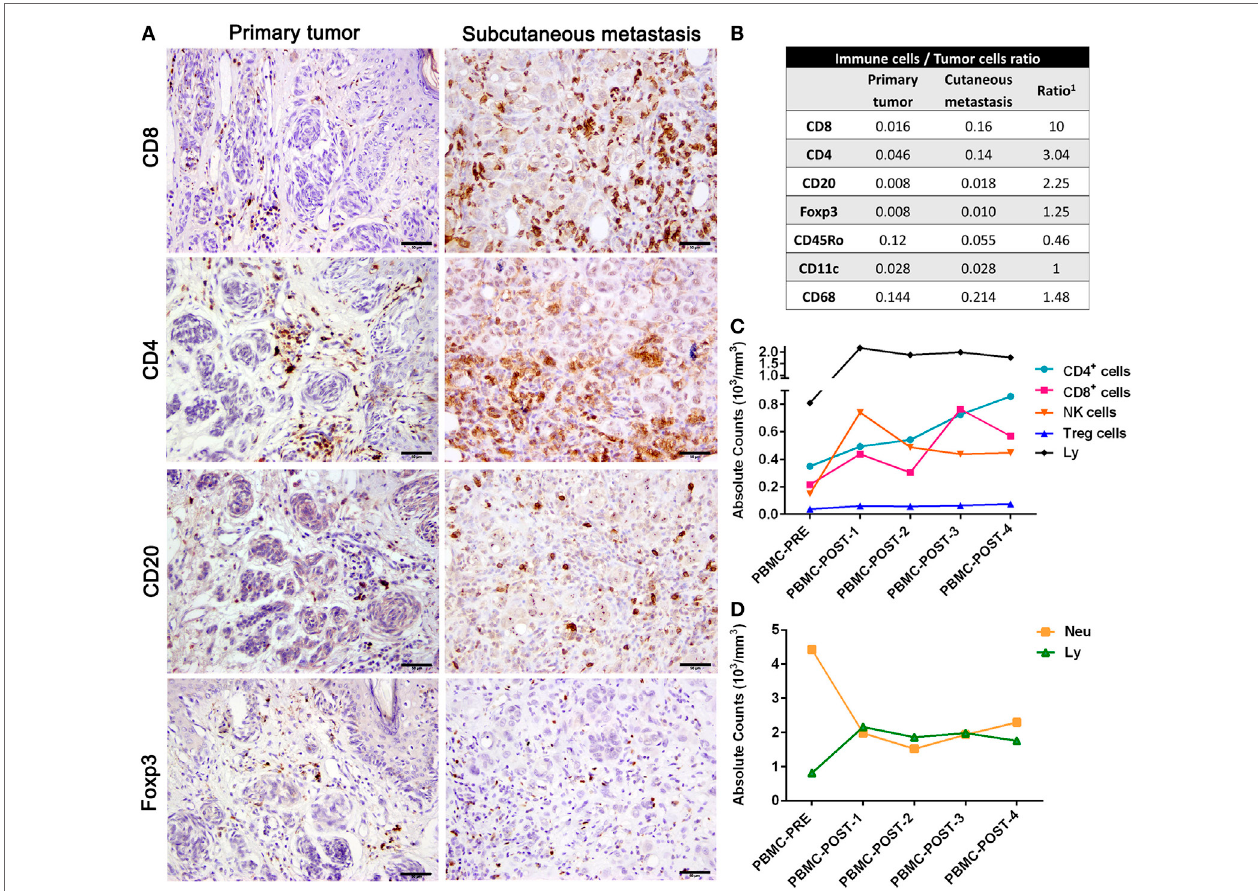
FIGURe 2 | Immune profiling of patient #006. (a) Representative pictures of the primary tumor and subcutaneous metastasis biopsies infiltrated by CD8 + , CD4 + , CD20 + , and Foxp3 lymphocytes determined by IHC (DAB, brown). (B) After counting total biopsy area, immune-to-tumor cell ratios were determined for each tumor biopsy as well as the relative ratio between primary tumor and SC metastasis ( 1 ). (C) Absolute counts of total lymphocytes, T CD4 + , T CD8 + , Treg, and NK cells from PBMC were determined throughout CASVAC-0401 treatment and follow-up by flow cytometry; also, absolute counts of lymphocytes (Ly) and neutrophils (Neu) are shown (D) . Scale bars = 50